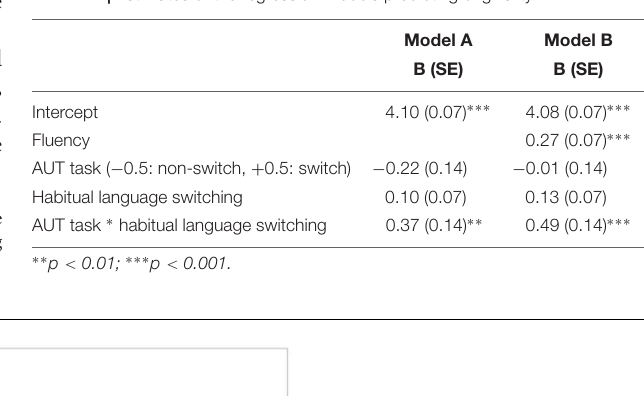
Frontiers in Psychology |